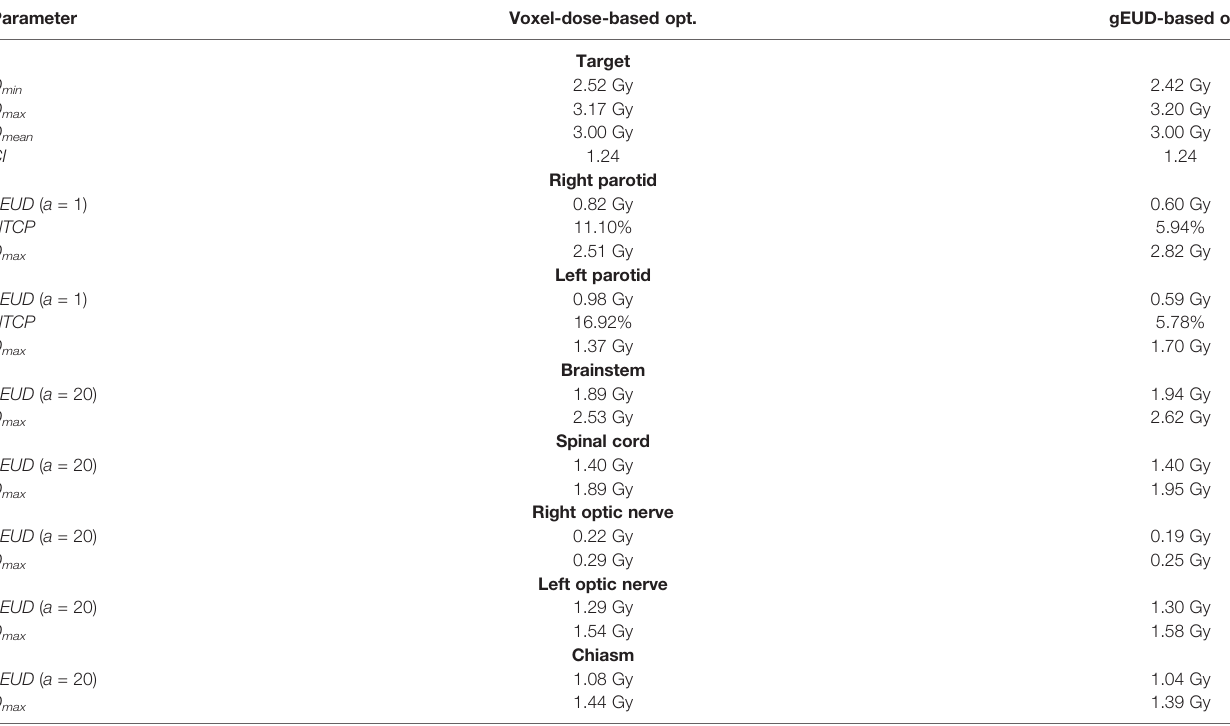
TABLE 4 | gEUD, NTCP and other indexes for the VOIs of plan 335, considering both parotid glands. Parameter Voxel-dose-based opt.